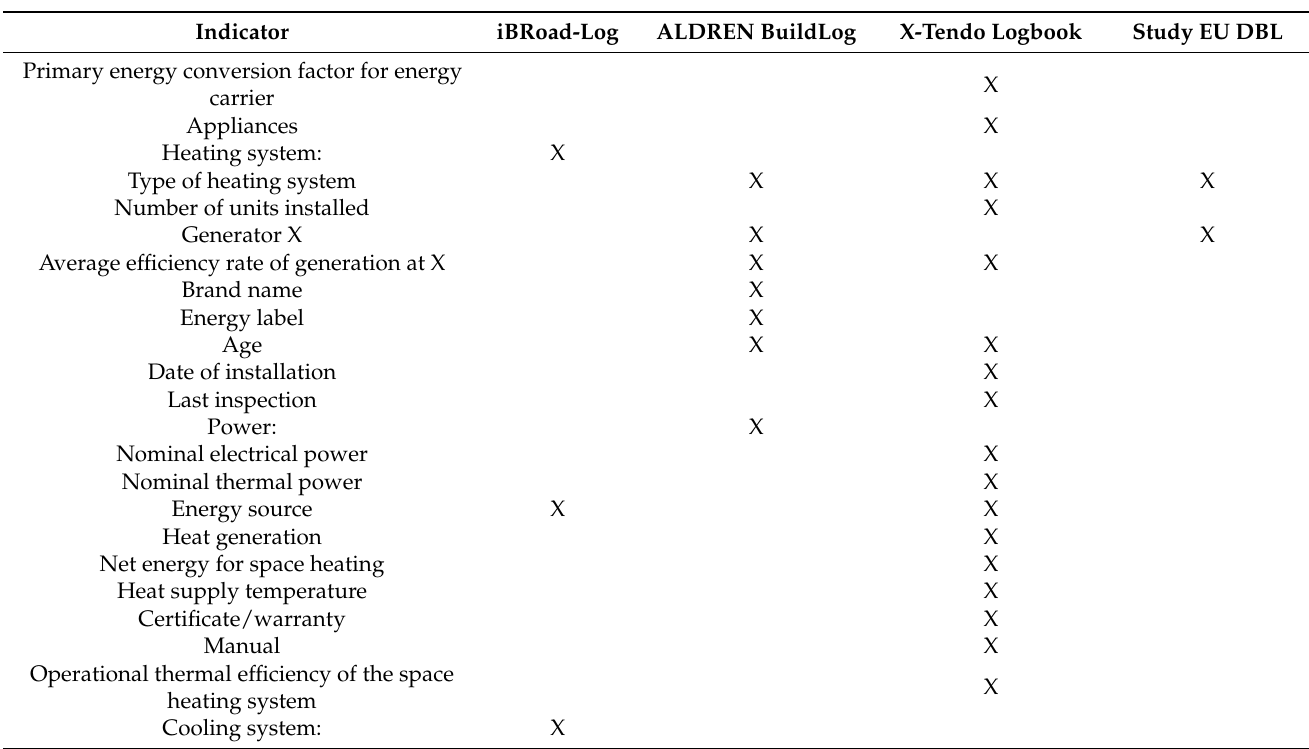
Table A3. Module 3: building technical systems and smart